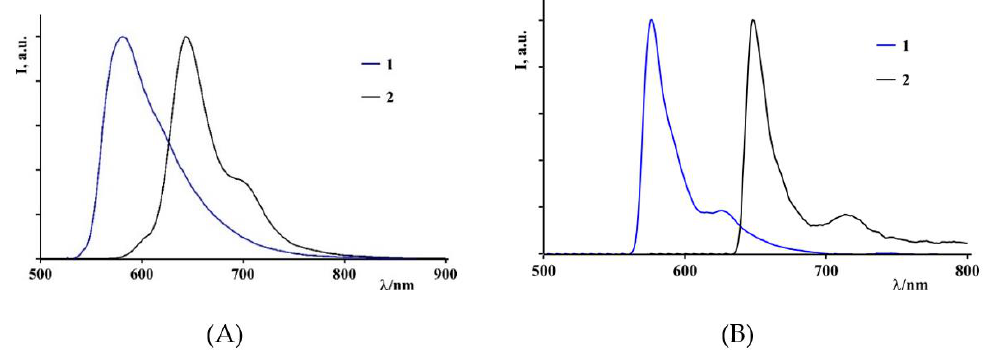
Figure 5. ( A ) Emission spectra of BODIPY 1 (blue line) and BODIPY 2 (black line) in acetonitrile at 298 K. ( B ) Emission spectra of BODIPY 1 (blue line) and BODIPY 2 (black line) in butyronitrile at 77 K. Table 2. Redox data of BODIPY 1 and 2